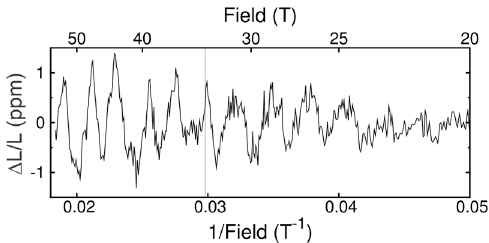
Figure 7. Magnetostrictive quantum oscillations in GdSb at 2 K taken in a 55 T mid-pulse magnet using the method described in Section 2.2. The resolution achieved in this measurement is considerably better than 10 − 6 [9].